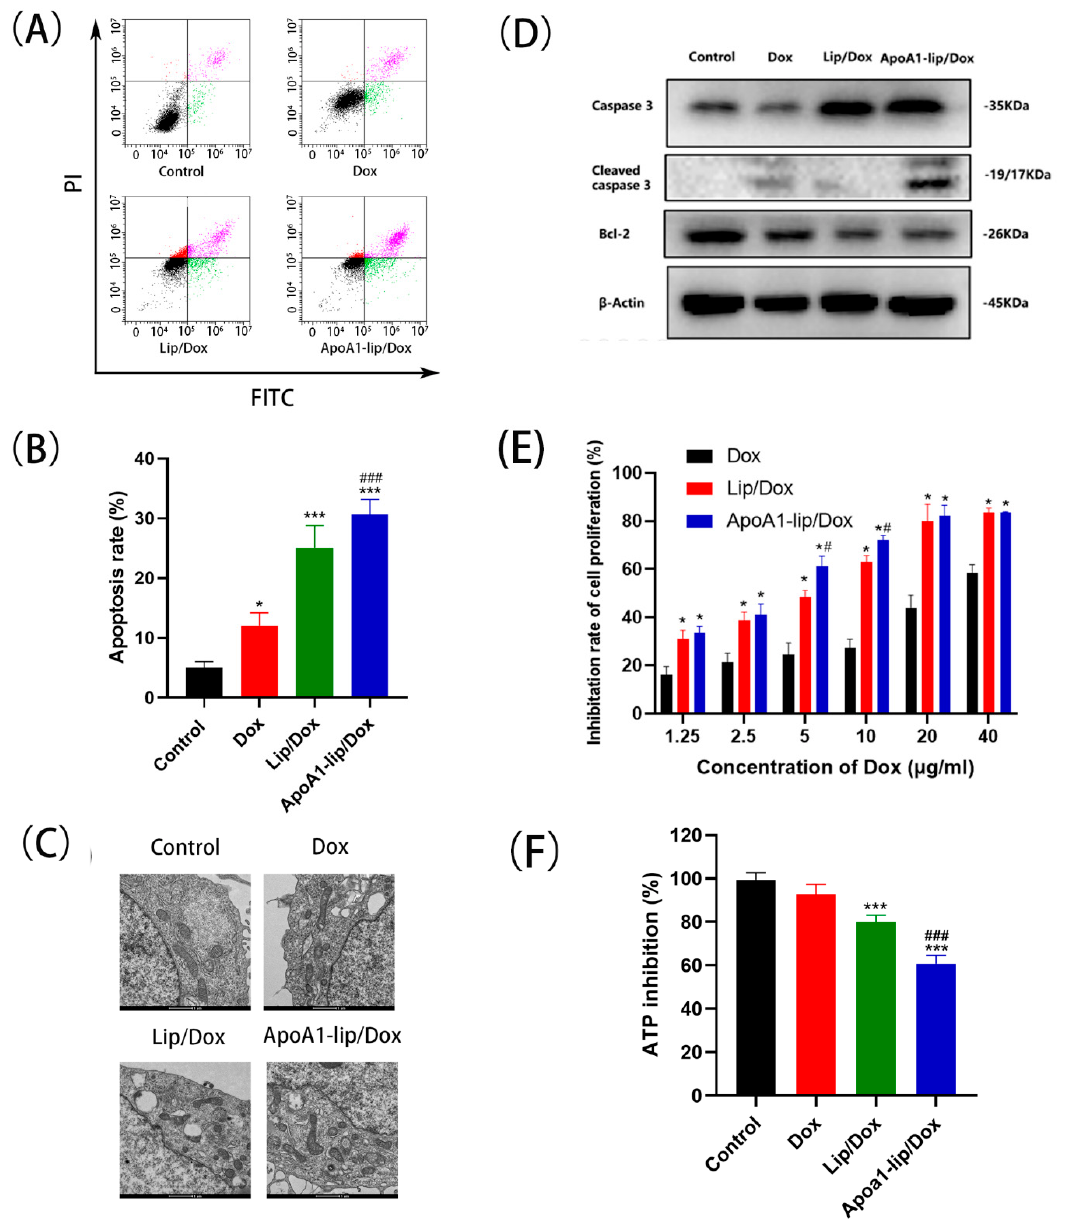
Figure 4. ( A , B ) Apoptosis of MCF-7/ADR cells induced by different Dox formulations after 12 h of incubation determined using the Annexin V-FITC/PI staining. ( C ) Transmission electron microscopical images of MCF-7/ADR cells treated with different drug formulations. ( D ) The levels of apoptotic related proteins in MCF-7/ADR after treatment with different formulations. ( E ) The inhibition rate of different Dox formulations on MCF-7/ADR cell proliferation. Data in the graph are presented as mean ± SD ( n = 3). * p < 0.05 versus Dox group; # p < 0.05 versus Lip/Dox group. ( F ) The adenosine triphosphate (ATP) inhibition of different Dox formulations on MCF-7/ADR cells. *** p < 0.01 versus control group; ### p < 0.01 versus Dox group.